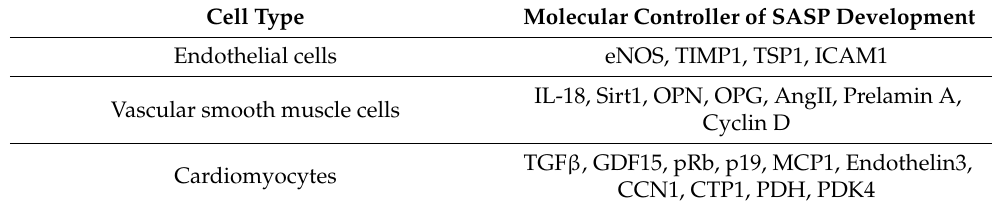
Figure 2. SASP factors involved in the formation of inflammaging in the local microenvironment of the cardiovascular system components. Table 1. Comparative cell type-specific molecular controller of SASP development.